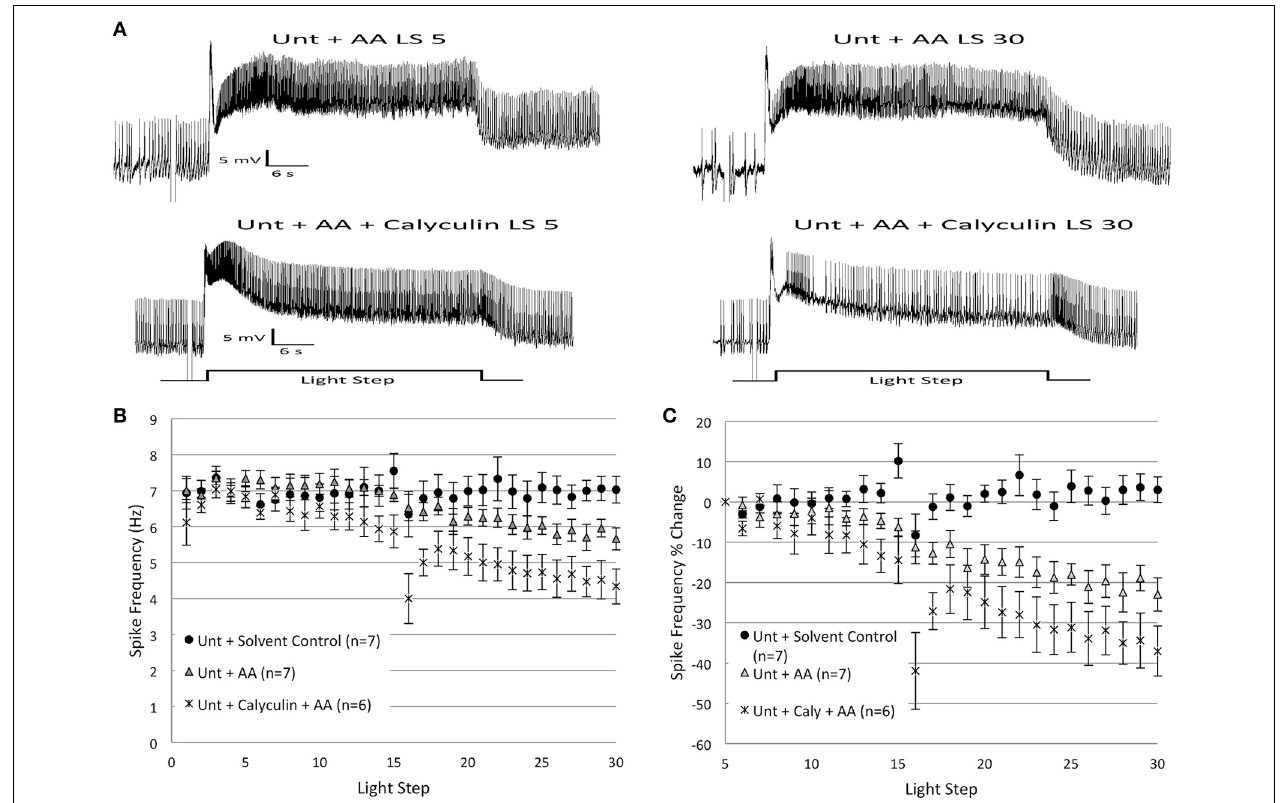
FIGURE 11 | Incubation of Untrained B cells in calyculin A (20nM final bath concentration) enhanced the reduction in spike frequencies produced by arachidonic acid (AA; 100 µ M final bath concentration). (A) Representative light responses recorded from an Untrained Type B cell exposed to AA ( Unt + AA ; top trace) or calyculin followed by AA ( Unt + Calyculin + AA ; bottom trace). (B) Summary spike frequency data over 30 LSs of Type B cells exposed to AA or calyculin. Unt + AA cells exhibited decreases in spike frequencies compared to Unt + Solvent control cells (significant interaction between